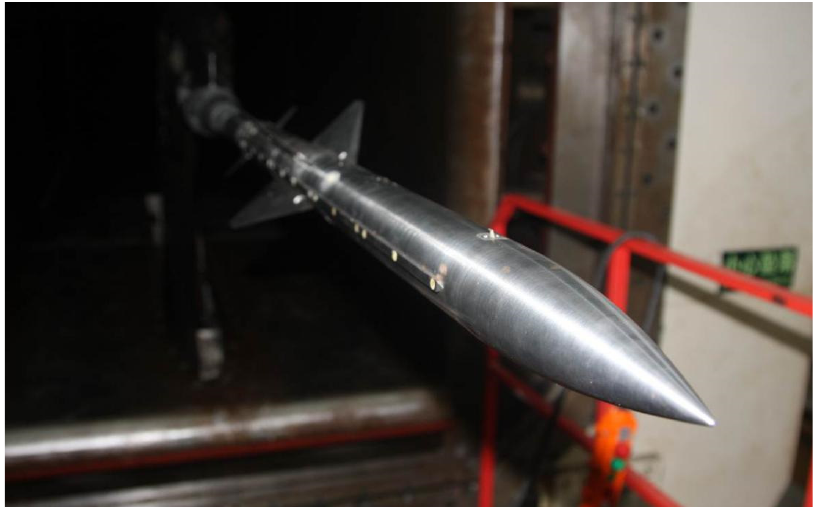
Figure 6. Model photographs. Figure 6. Model